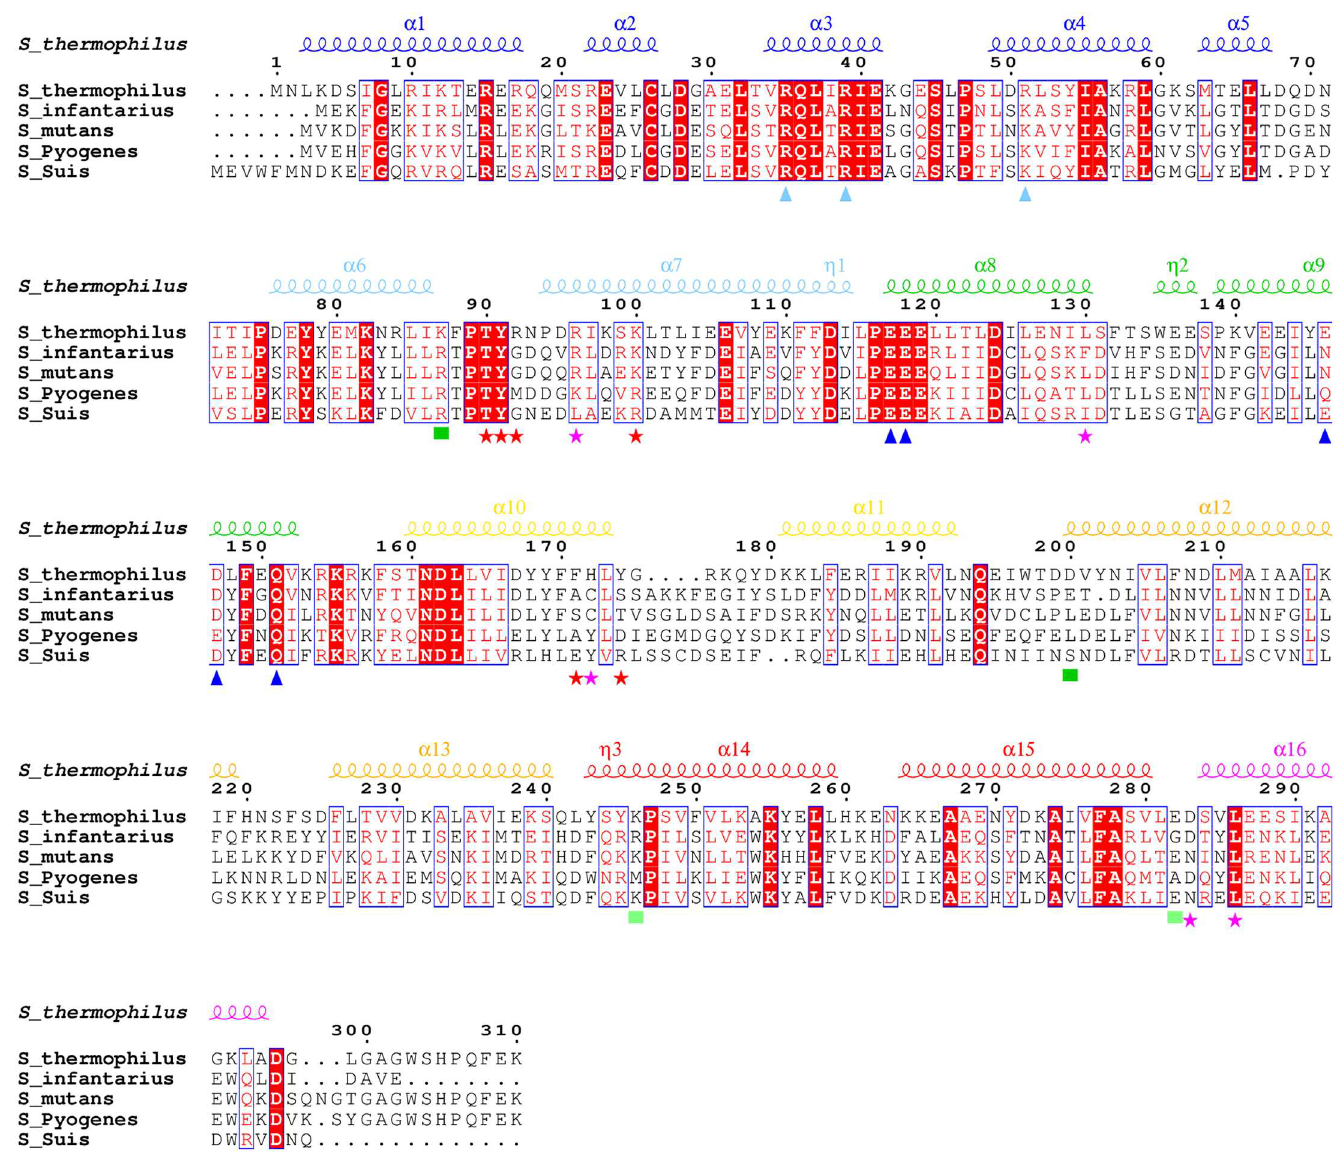
Fig 3. Sequence alignment of representative ComR orthologues. The ComR apo secondarystructure elementsof apo ComR are indicatedat the top of the alignment.The α -helicesare coloured accordingto Fig 1A. Strictly conservedresidues are highlightedwith red background and white labels. Conserved residues are written in red in blue frames. The similarity score has been calculatedusing the Rissler matrix [48]. Functionally important residues are highlightedwith distinct signs at the bottom of the alignment: cyan trianglesfor DNA bindingand HTH sequestration (R35, R39 and R51); blue trianglesfor HTH sequestration (E117, E118, E146, D147); green squaresfor dimerization(R87, D200, K246, E282); red stars for mutated residues (T90, Y91, R92, K100, F171, Y174) and pink stars for other discussedresidues (R96, L130, H172, D283, L286). The sequencealignment initiallygeneratedby Clustal Ω [49] displaysComR from S . thermophilus LMD-9 (GenBank ABJ65625.1)and 4 homologues (UniProt numbers) that were experimentally validatedas functionalfor competence activation: S . infantarius (H6PCI7), S . mutans (Q8DWI6), S . pyogenes (Q9A1Y2), S . suis (A4VSD6). The formatting of the multiplealignment has been generatedusing Espript